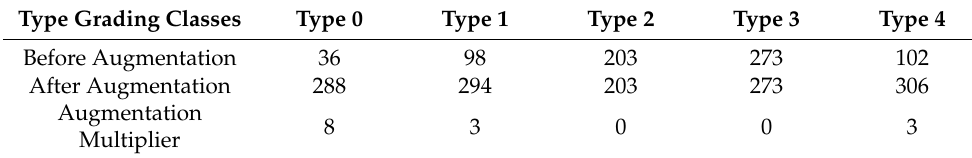
Table 3. Augmentation Process for Type Grading Classes.